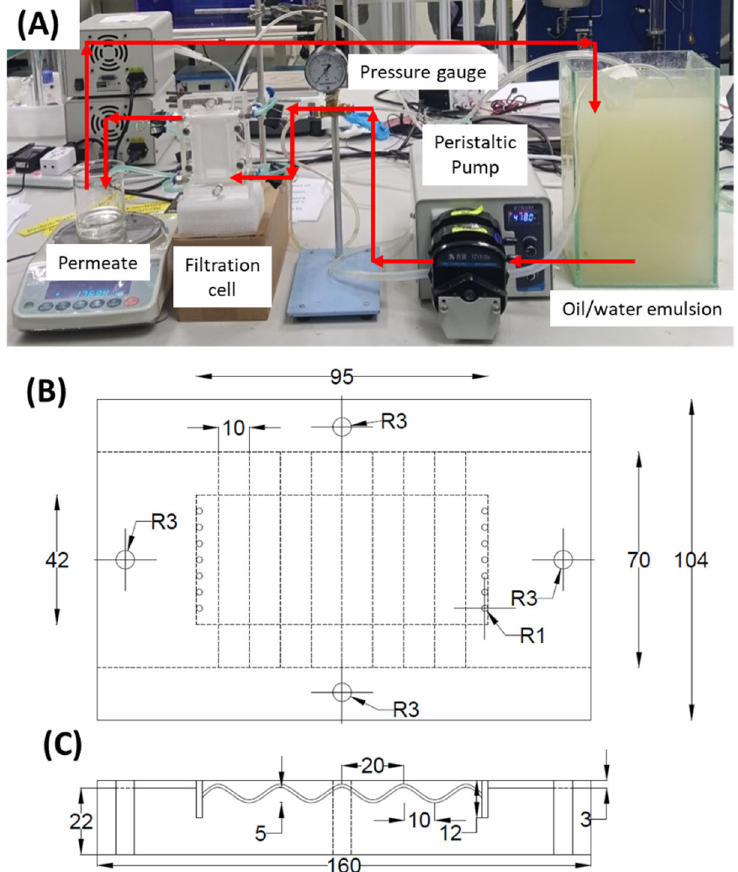
Figure 1. ( A ) Picture of the crossflow filtration setup, also showing the design and dimensions of the filtration cell with a wavy flow channel viewed from the top ( B ) and the side ( C ).